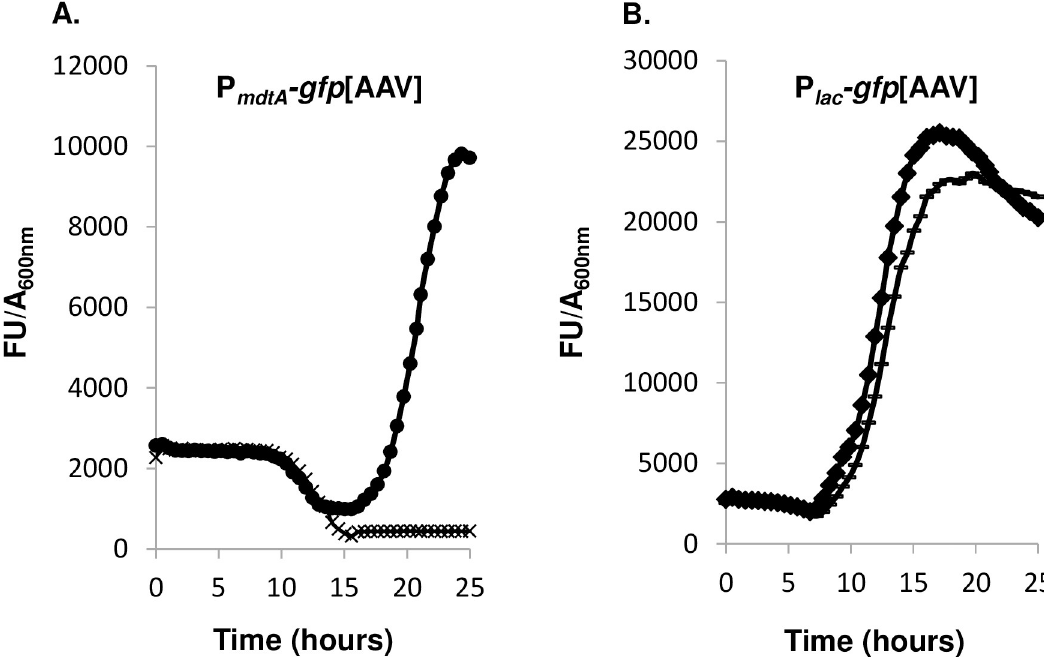
Fig 7. Cysteine and serine protease inhibitors prevent expression of the mdtABC operon. TT01 strains carrying the P mdtA –gfp [AAV] (A) or P lac –gfp [AAV] (B) fusions were grown in LB medium containing HO extracts and supplemented ( × and □ ) or not supplemented ( ● and ♦ ) with complete mini EDTA-free protease inhibitor. Specific fluorescence is expressed as the ratio of GFP fluorescence units (FU) to A 600nm value. The results are representative of three independent assays.